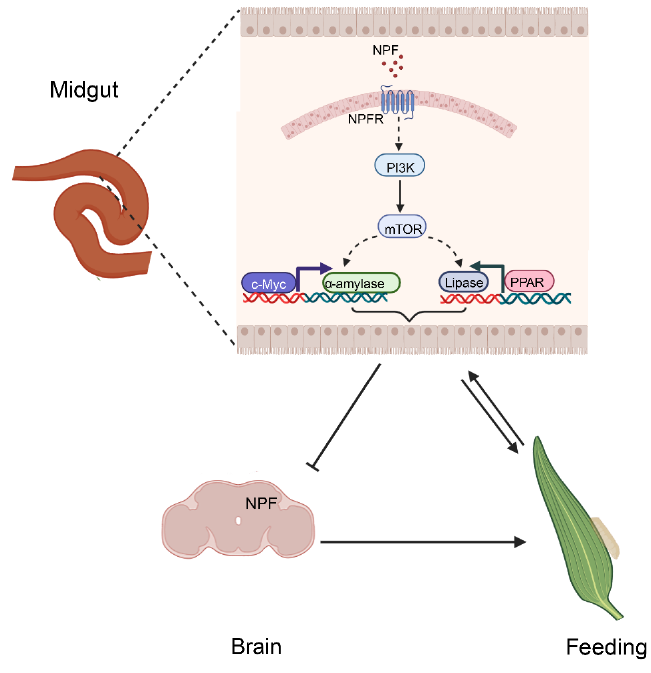
Figure 10. Schematic representation of the NPF signalling pathway cascade in feeding and digestion in the midgut of O. furnacalis . Supplementary Materials: The following supporting information can be downloaded at: www.mdpi.com/xxx/s, Figure S1: Schematic diagram of the ds RNA production system; Figure S2: Effects of RNA interruption; Figure S3: The relationship between NPF and PDK/AKT/PKC in insulin pathway in midgut of O. furnacalis ; Figure S4: The nucleotide promoter sequences of α -amylase; Figure S5: The nucle- otide promoter sequences of lipase; Table S1: Primer sequences of synthesis dsRNA used for larval treatment via diet-feeding; Table S2: Primer sequences of synthesis dsRNA used for larval treatment via injection; Table S3: Primer sequences for the qPCR assay; Table S4: Primer sequences for dual luciferase reporter assay. Au- thor Contributions: Z.Z. and L.W. supervised the project and designed the experiments; J.Z., Y.S., X.J., and L.H. performed the experiments and data analysis; Z.Z. contributed reagents, materials, and analysis tools; J.Z. wrote the paper, and Z.Z. edited and reviewed the paper. All authors have read and agreed to the published version of the manuscript. Funding: The work was supported by the National Natural Science Foundation of China (Grant numbers 31730076) to Z.Z. Institutional Review Board Statement: Not applicable Informed Consent Statement: Informed consent was obtained from all individual participants in- cluded in the study. Data Availability Statement: The datasets generated during and/or analysed during the current study are available from the corresponding author on reasonable request. Acknowledgments: We thank Yi Rao (Peking University) and Yan Zhu (Chinese Academy of Sci- ences, China) for providing Drosophila lines. Conflicts of Interest: The authors have no relevant financial or non-financial interests to disclose. Ethics Approval and Consent to Participate: This article does not contain any studies with human or mammal subjects.